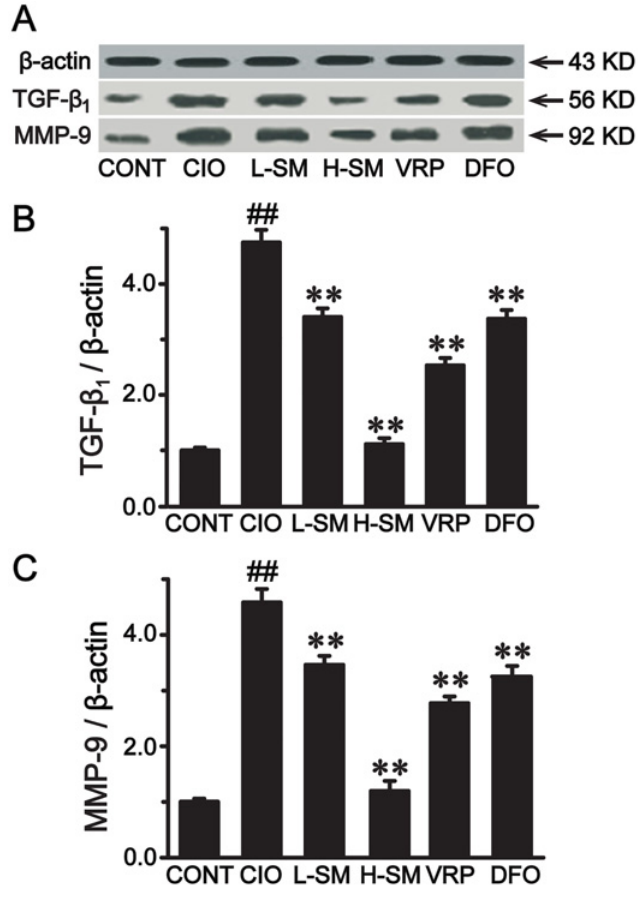
Fig 5. Effects of SM treatment on expression levels of TGF- β 1 and MMP-9 by Western blot analysis. Representative immunoblots of TGF- β 1 and MMP-9 expression in each group are shown (A). Relative intensities of TGF- β 1 (B) and MMP-9 (C) were calculated by normalization to that of β -actin in each group. Values are means ± SEM. ## P < 0.01 vs. CONT group; ** P < 0.01 vs. CIO group.